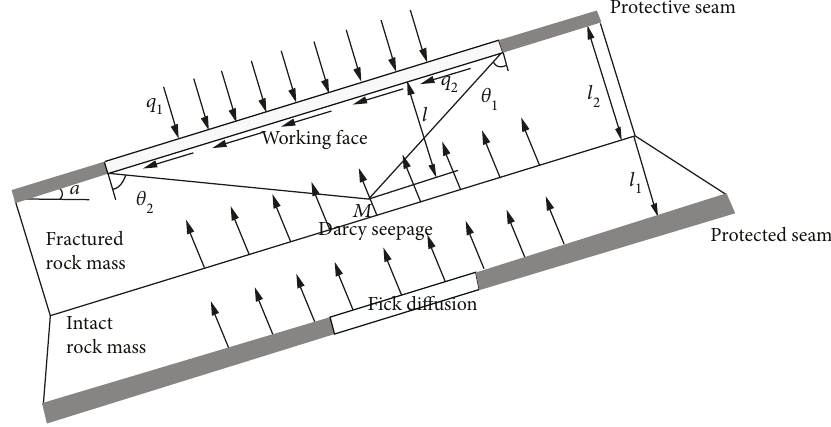
Figure 2: Coal seam gas di ff usion and